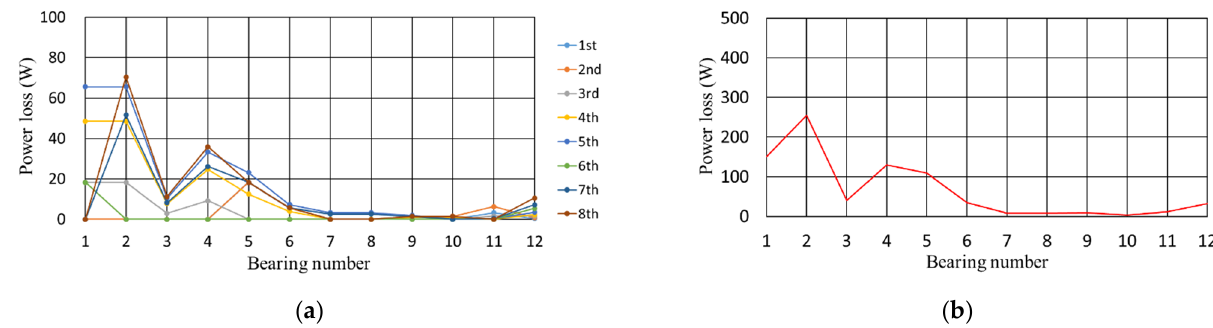
Figure 9. ( a ) Bearing spin power losses for the forward drives and ( b ) spin power losses of the total amounts of the forward drives.